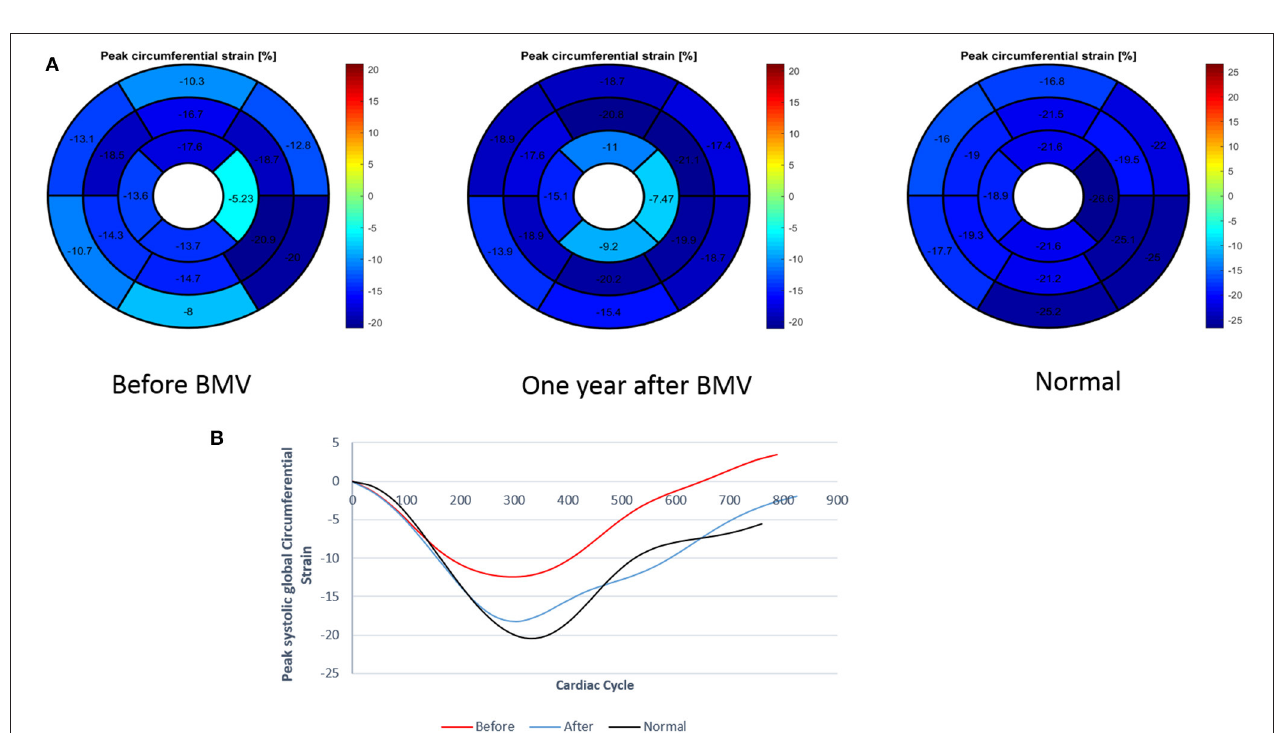
FIGURE 3 | (A) Measurement of regional and global circumferential strain (Bull’s eye plot) in a patient with mitral stenosis before and 1 year after BMV with comparison to a control individual (B) Graph representation of GCS in a patient with mitral stenosis before and after BMV in comparison to a control